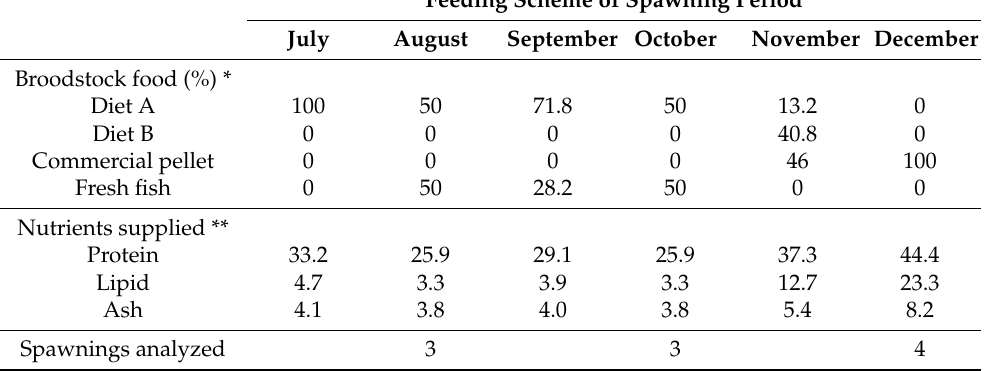
Table 1. Feeding scheme and nutrients ingested by Seriola lalandi broodstock during the spawning period studied.